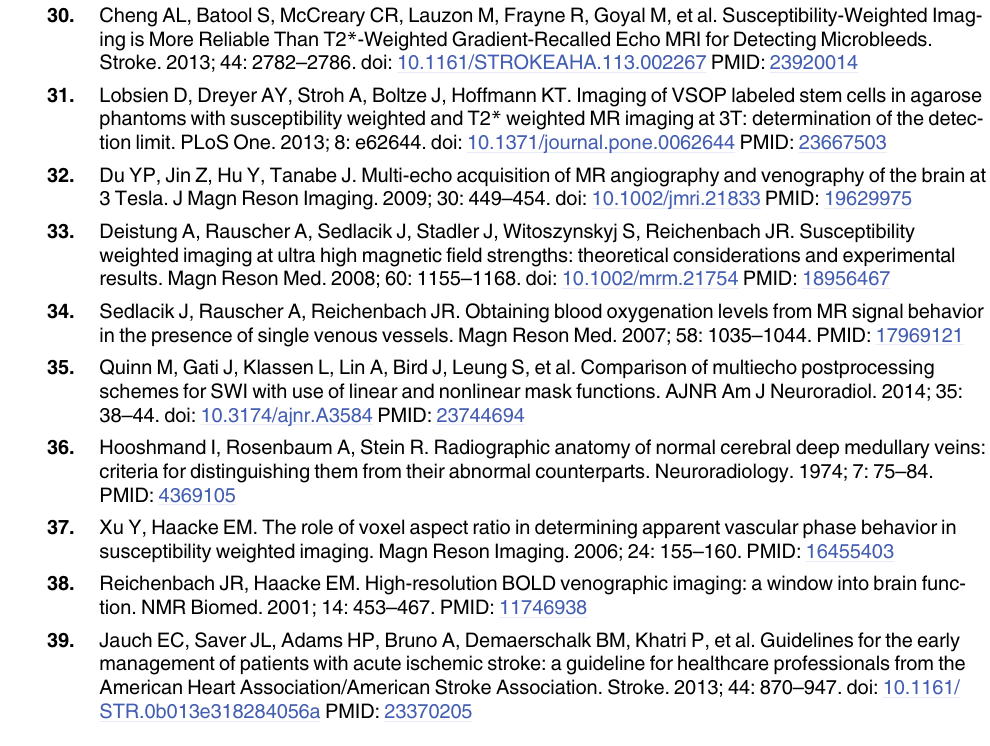
PLOS ONE | DOI:10.1371/journal.pone.0159251 August 5,